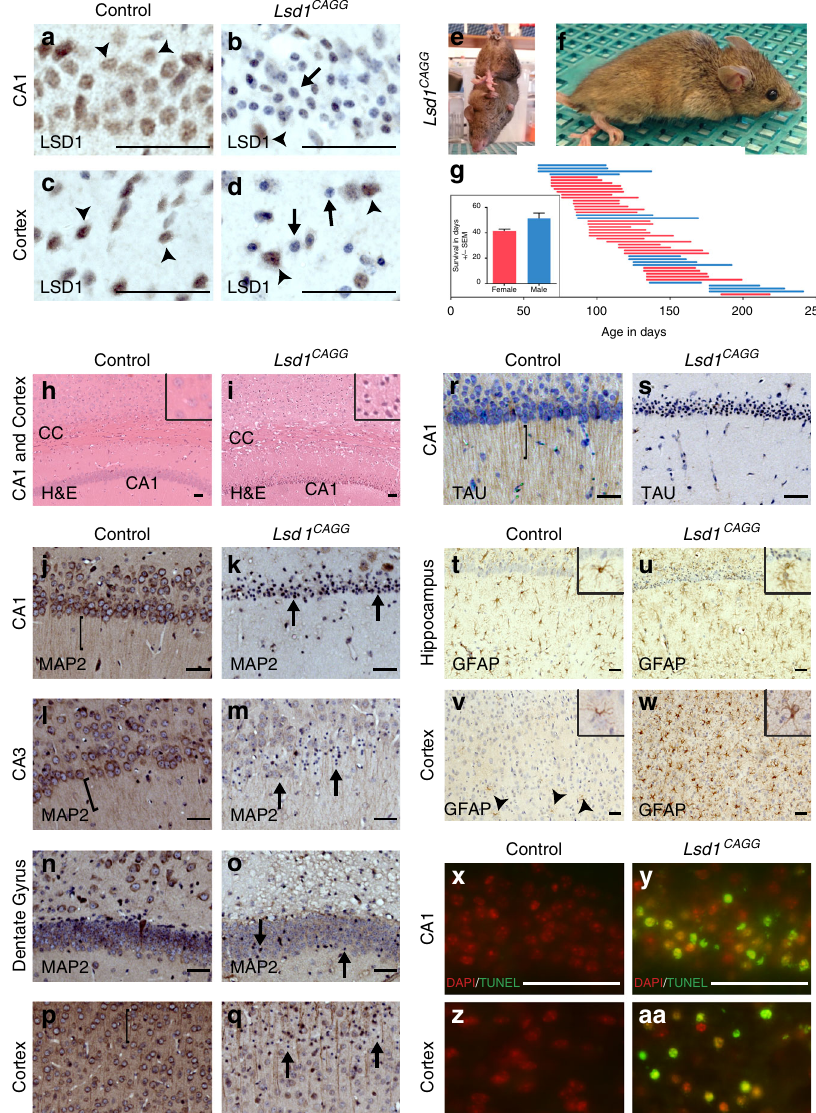
Fig. 1 Neurodegeneration in Lsd1 CAGG mice. a – d LSD1 immunohistochemistry (IHC) of control a , c and Lsd1 CAGG b , d CA1 a , b and cortex c , d . Arrowheads highlight non-pyknotic LSD1 immunoreactive nuclei. Arrows highlight pyknotic LSD1 negative nuclei. e , f Representative images of Lsd1 CAGG mice with the terminal motor defect including hindlimb clasping e and failure to maintain posture f . g The age of each individual male (blue) or female (red) mouse at the fi nal tamoxifen injection (start of each line) to inducibly delete Lsd1 , and the number of days (length of the line) until the terminal motor defect is reached. Inset shows survival in days for each sex. Data are shown as mean survival in days ± s.e.m., n = 45 animals h , i H&E staining of tamoxifen injected Cre minus control (control) h and Lsd1 CAGG i CA1 and cortex. Insets are magni fi ed views of non-pyknotic h and pyknotic i nuclei. CC denotes corpus callosum. j – q MAP2 IHC of control j , l , n , p and Lsd1 CAGG k , m , o , q CA1 j , k , CA3 l , m , dentate gyrus n , o and cortex p , q . Brackets highlight dendrites and arrows highlight pyknotic nuclei. r , s Tau IHC of control r and Lsd1 CAGG s CA1. Bracket highlights axons. t – w GFAP IHC of control t , v and Lsd1 CAGG u , w hippocampus t , u and cortex v , w . Arrowheads highlight sparse astrocytes in control cortex. Insets show magni fi ed view of representative astrocytes. x − aa Merge of DAPI (red) and TUNEL (green) in control x , z and Lsd1 CAGG y , aa CA1 x , y and cortex z , aa . All IHC j – w is counterstained with hematoxylin. All Lsd1 CAGG images are taken at the terminal phenotype. Scale bar = 50 µ